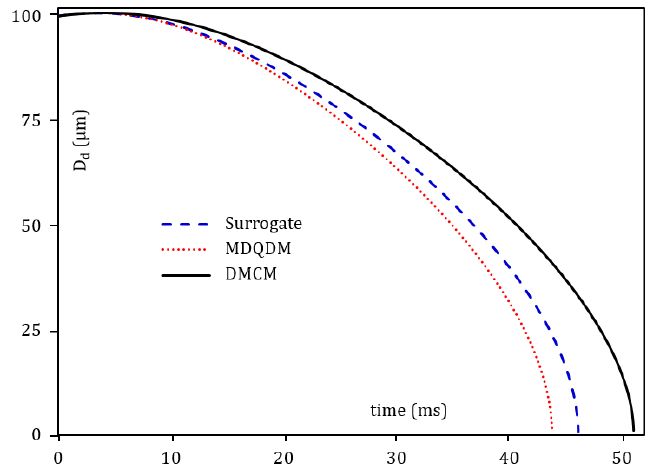
Figure 1. The droplet evaporation versus time for kerosene using the DMCM, MDQDM and surrogate (CFSM).